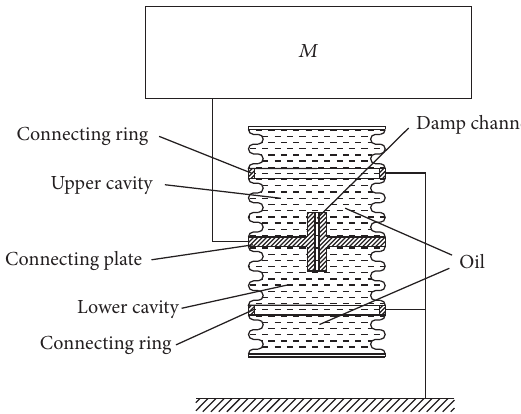
Figure 1: Structural diagram of the novel isolator with